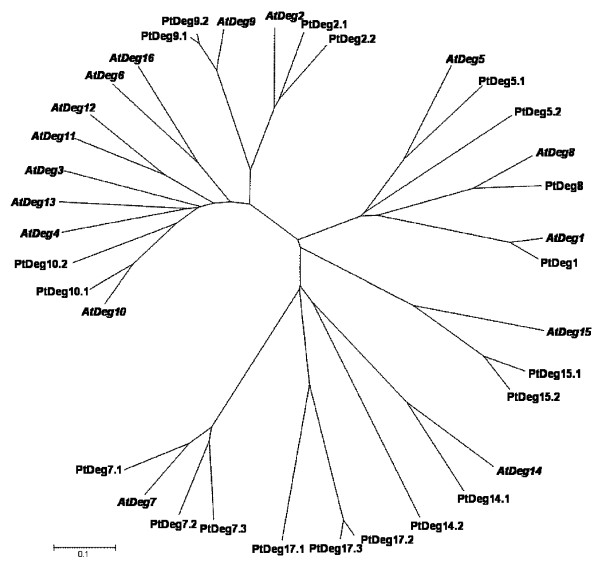
UPGMA (Unweighted Pair Group Method with Arithmetic Mean) tree of the Deg protease family (S1 family in MEROPS). The names and the accession numbers for the different proteins are given in Table 3.